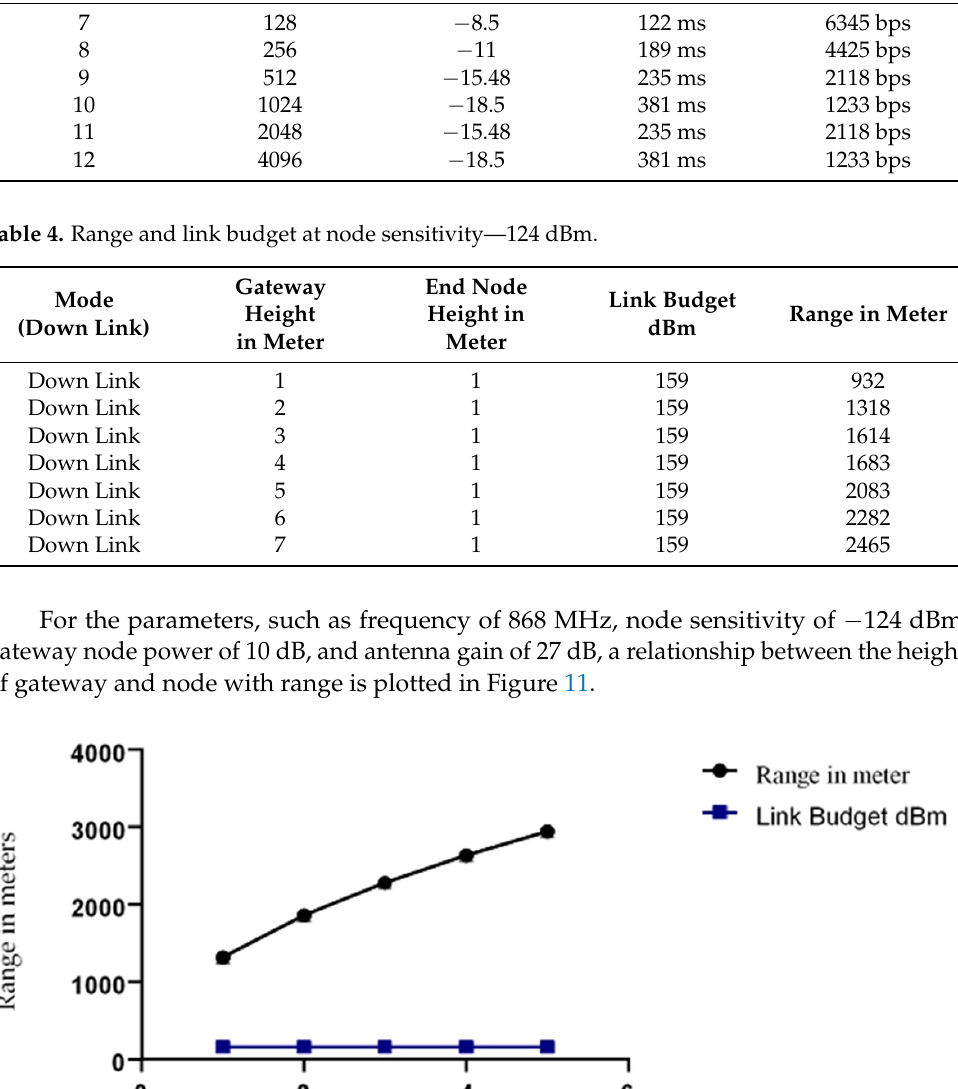
Table 3. Adaptive data rate of LoRa.